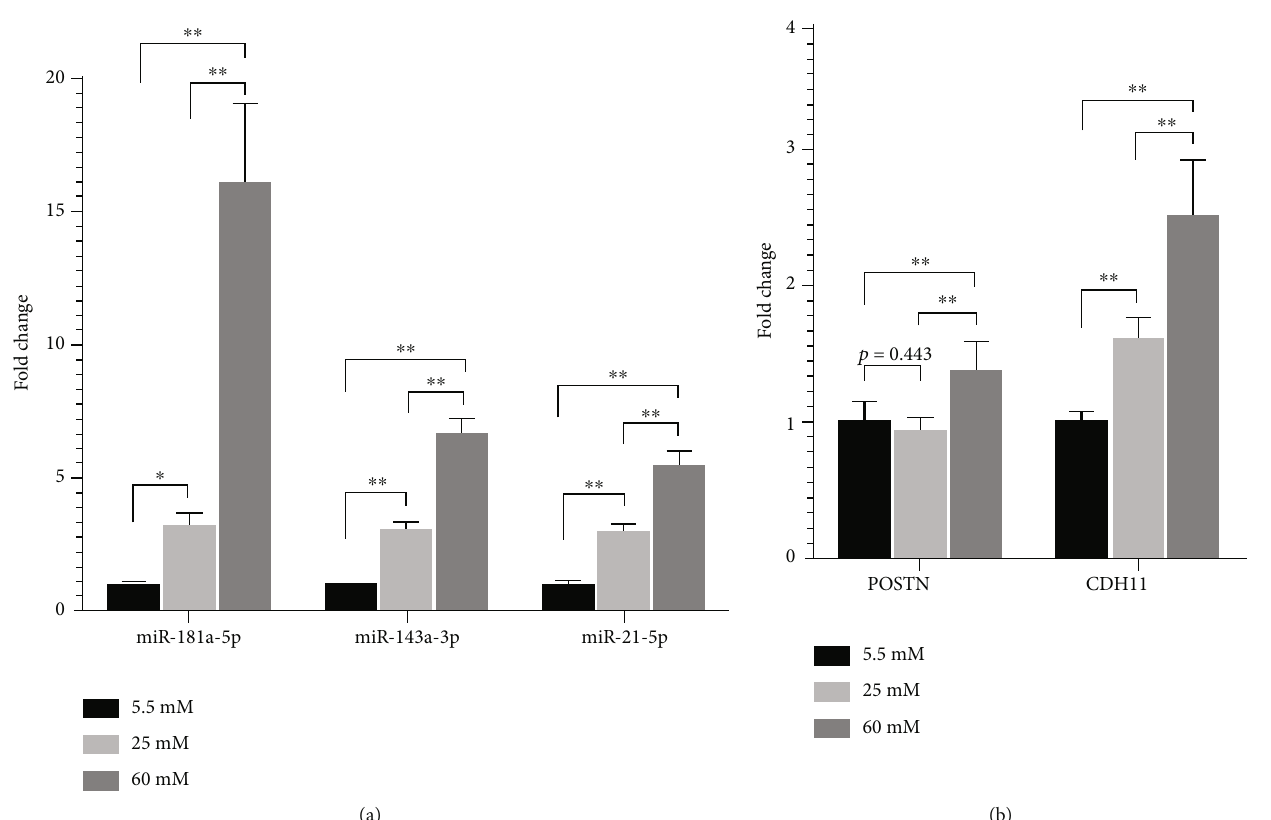
Figure 6: Validation of di ff erential expression of several miRNAs and mRNAs in di ff erent glucose concentration-cultured HDFs. (a) Expression of miR-181a-5p, miR-143a-5p, and miR-21-5p in di ff erent glucose concentration-cultured HDFs ( n = 6 ). (b) Expression of POSTN and CDH11 mRNAs in di ff erent glucose concentration-cultured HDFs ( n = 6 ). The fold changes were calculated by comparing to the normal glucose (5.5 mM) group. ∗ p < 0 : 05 , ∗∗ p < 0 : 01